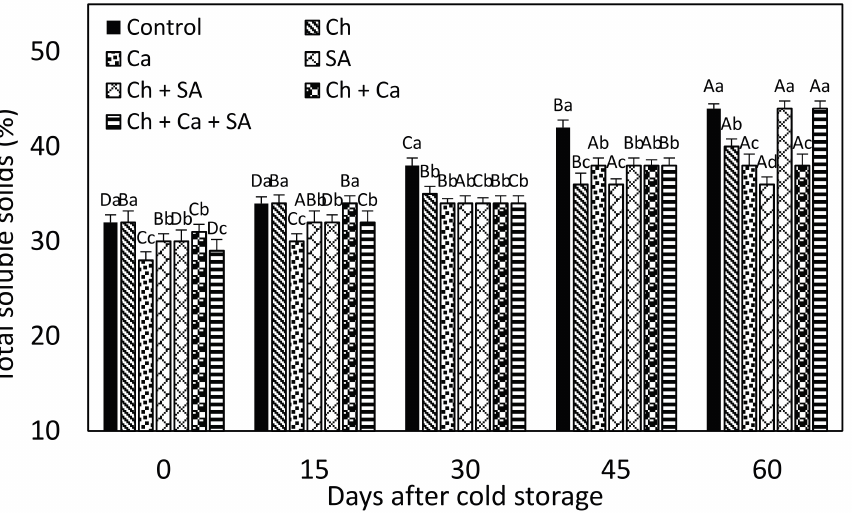
Figure 2. Effect of different preharvest treatments total soluble solids content of ‘Khesab’ fruit during cold storage, values are the mean ( n = 25) ± SE. Means with different letters between treatments (small letter) at different time interval (capital letter) are significantly different at p < 0.05 using LSD test. Ch: chitosan; Ca: calcium chloride; SA: salicylic